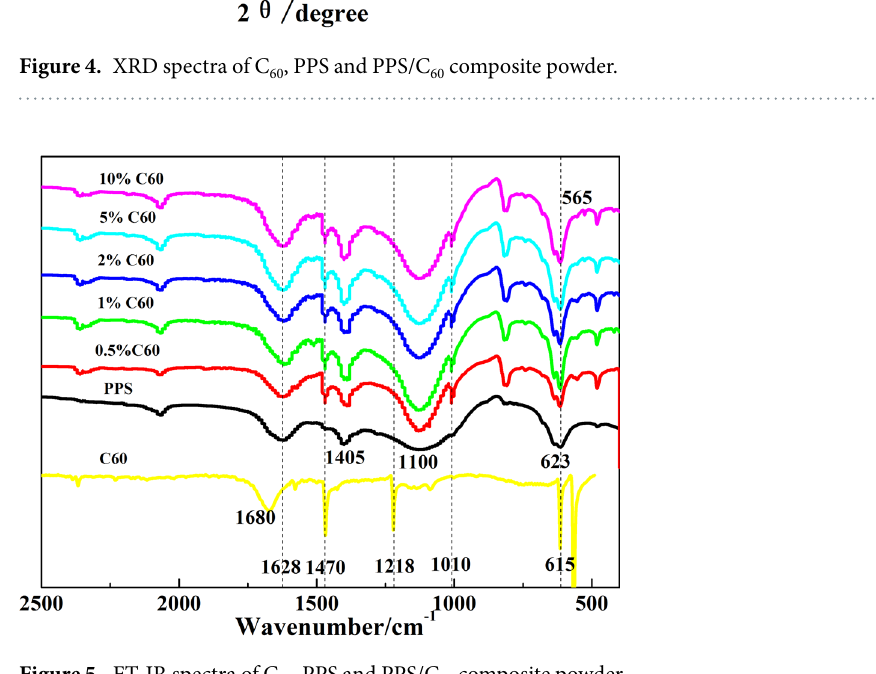
Figure 5. FT-IR spectra of C 60 , PPS and PPS/C 60 composite